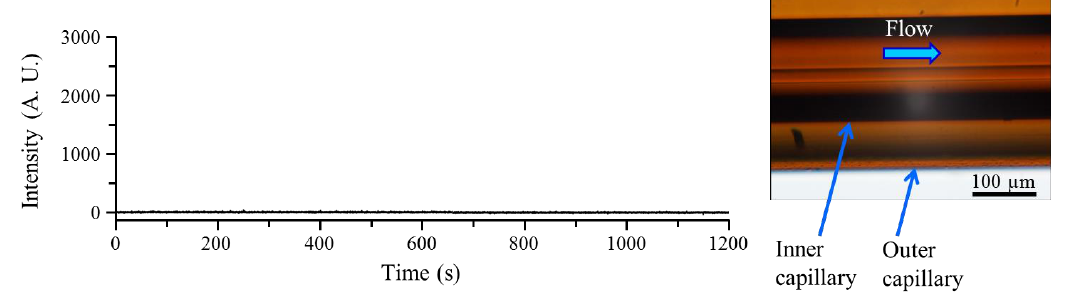
Figure 2. Time profile for toluene in an oil-in-water (O/W) emulsion after creaming that appeared transparent. The time profile was obtained by extracting the peak areas at m / z 92 and 91 (see text). The bright-field image of a sample flowing through an inner capillary column is also shown.